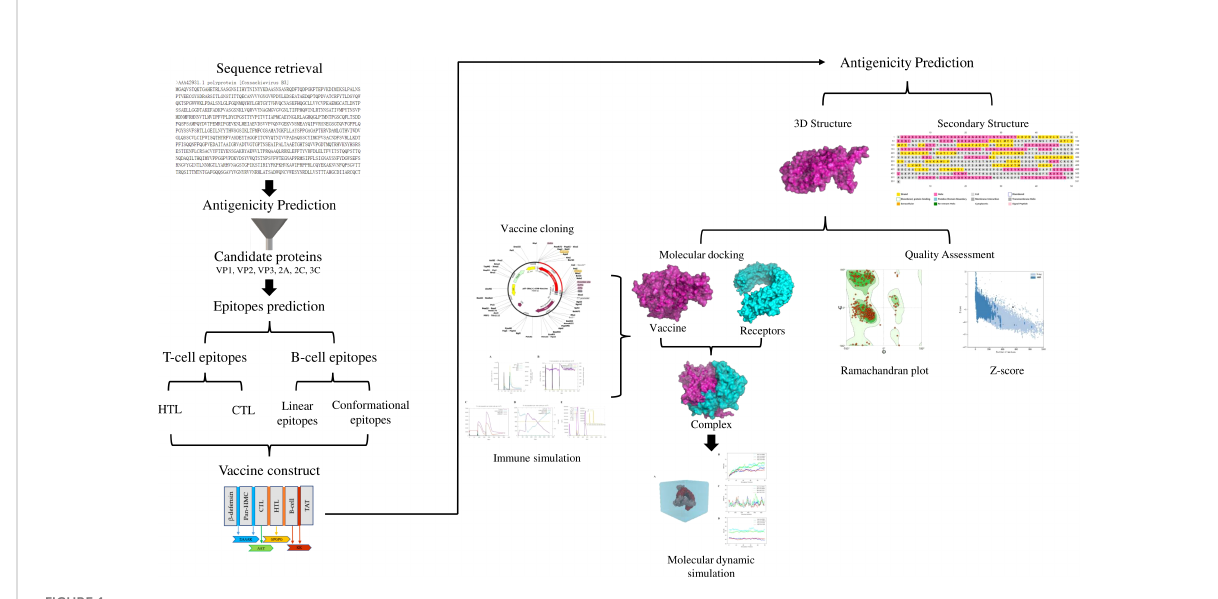
FIGURE 1 Flow diagram of the multi-epitope vaccine design in this